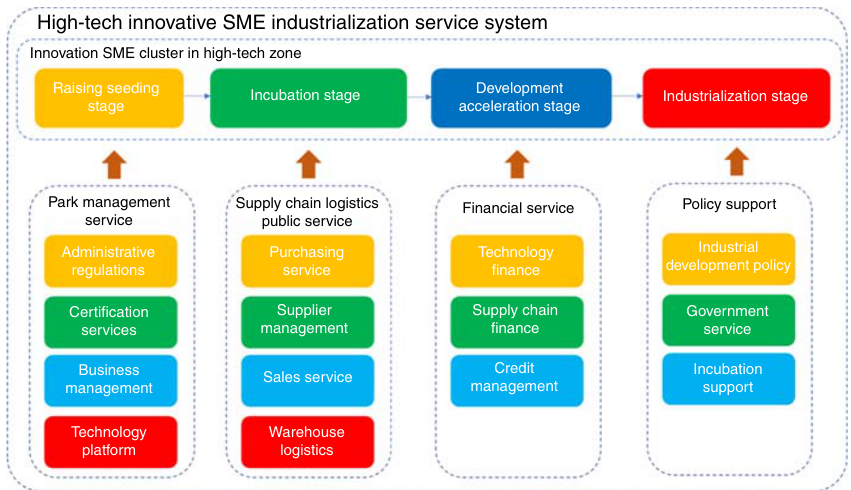
Figure 5. High-tech innovative SME industrialization service